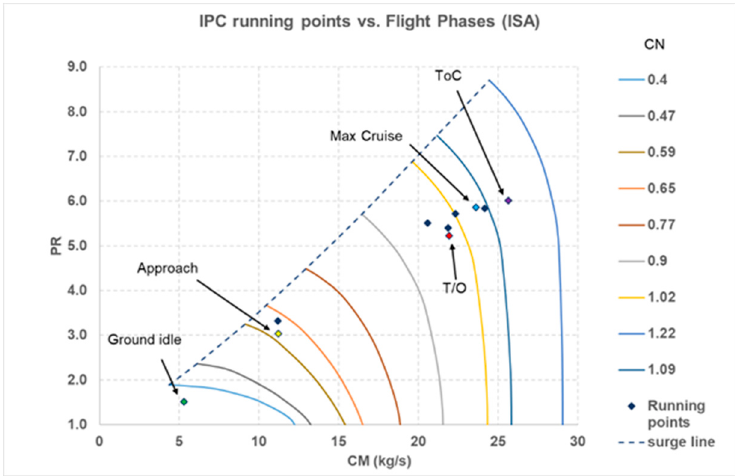
Figure 9. IPC running points at different flight phases (ISA).